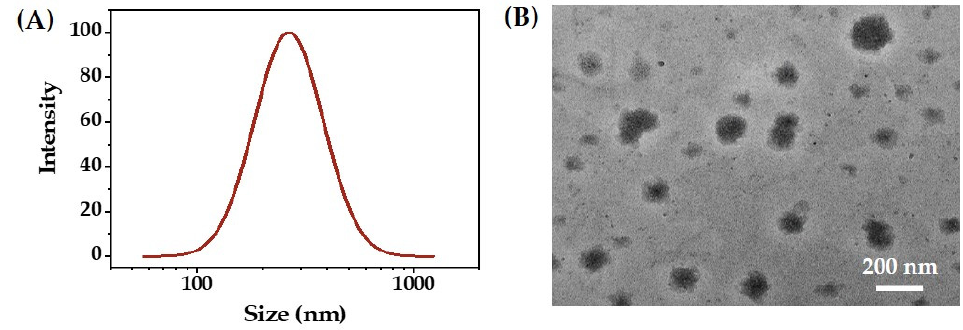
Figure 7. The droplet size distribution ( A ) and TEM image ( B ) of the curcumin O/W emulsion.